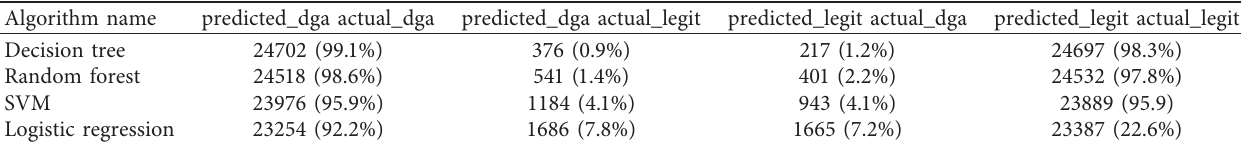
Table 3: Comparison and evaluation of machine learning models with the main analysis component.